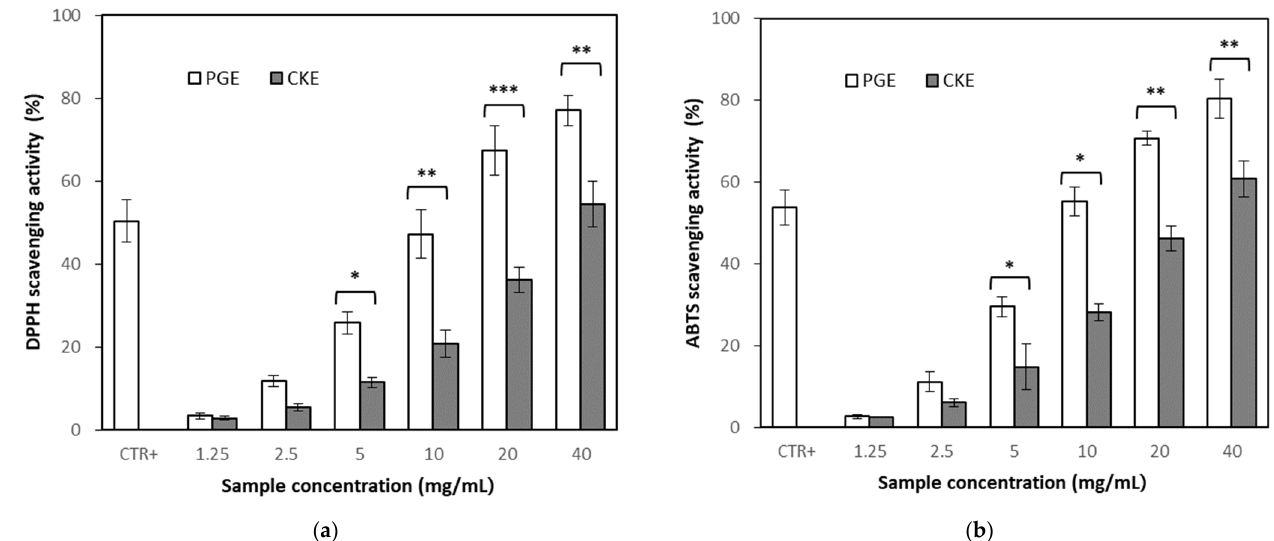
Figure 2. Antioxidant effects of partially purified ginsenoside extract (PGE) and compound K enriched extract (CKE). Result expressed as a mean ± SD ( n = 3). ( a ) on 1,1 ‐ diphenyl ‐ 2 ‐ picrylhydrazyl (DPPH) scavenging assay, ( b ) 2,2 ′‐ azino ‐ bis ‐ 3 ‐ ethylbenzthiazoline ‐ 6 ‐ sulphonic acid (ABTS) scavenging assay. CTR+, Positive control (ascorbic acid, 0.10 ± 0.01 mg/mL). An asterisk indicates a significant difference between the PGE and CKE at each concentration (*, p < 0.05; **, p < 0.01; ***, p < 0.001).